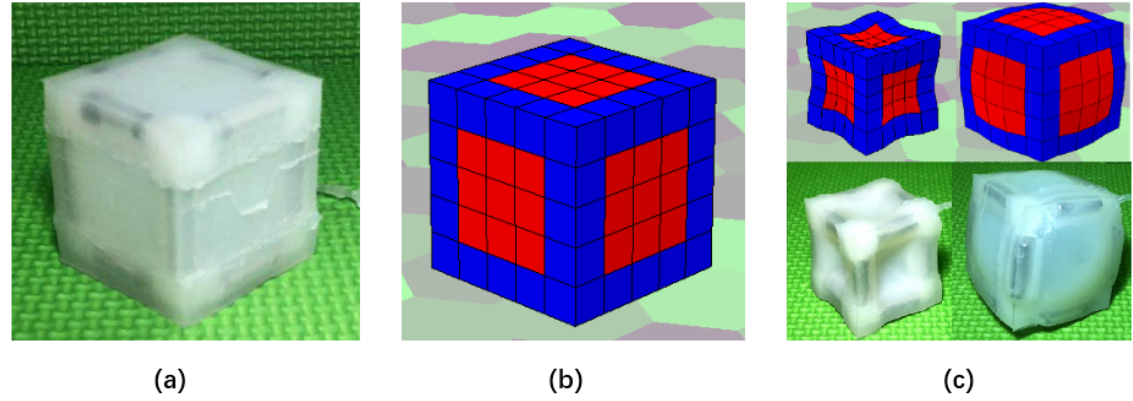
Figure 5. ( a ) The actual soft cube. ( b ) The simulation model. ( c ) The single soft cube expanding and contracting in the simulation software and actual